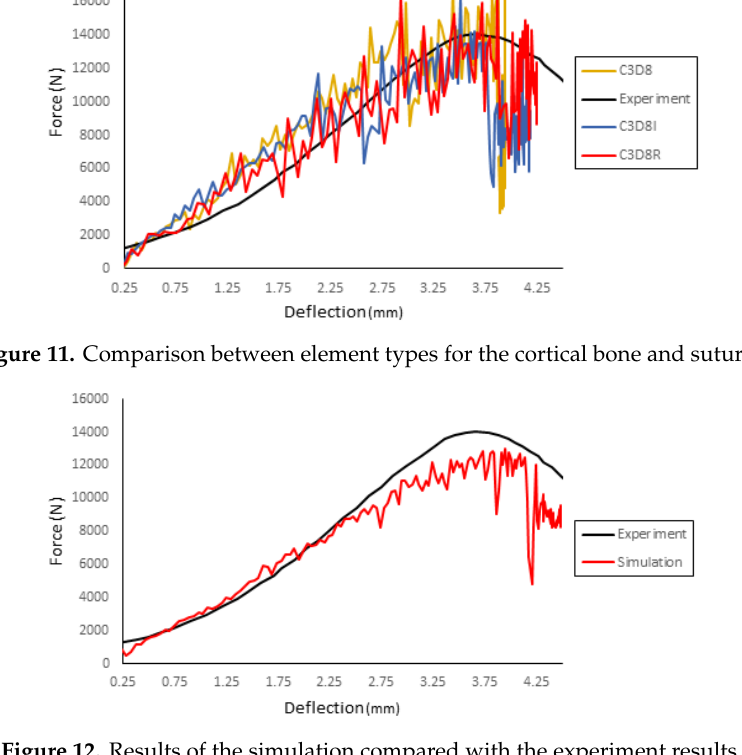
Figure 12. Results of the simulation compared with the experiment results.